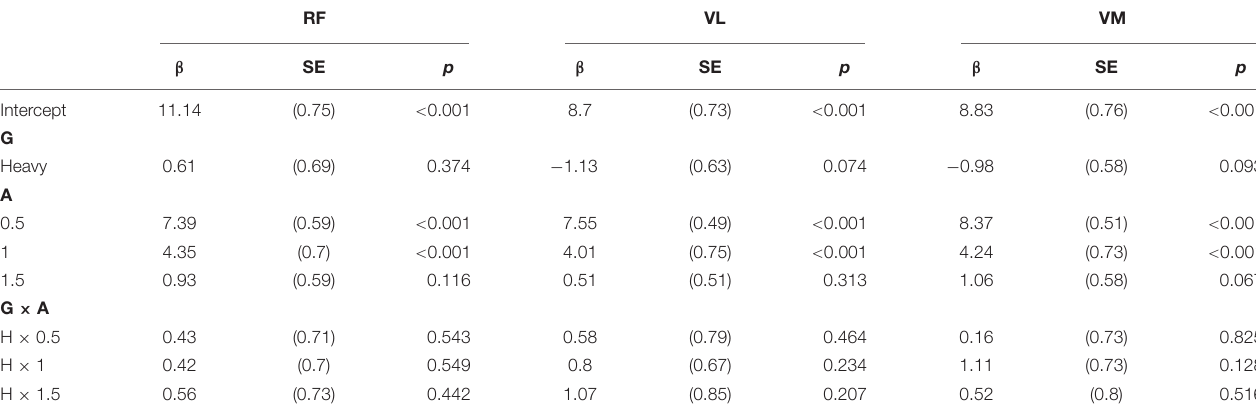
TABLE 3 | Coefficients ( β ), standard errors (SE), and p -values of biomechanics responses in 1.0% slope conditions. RF VL VM